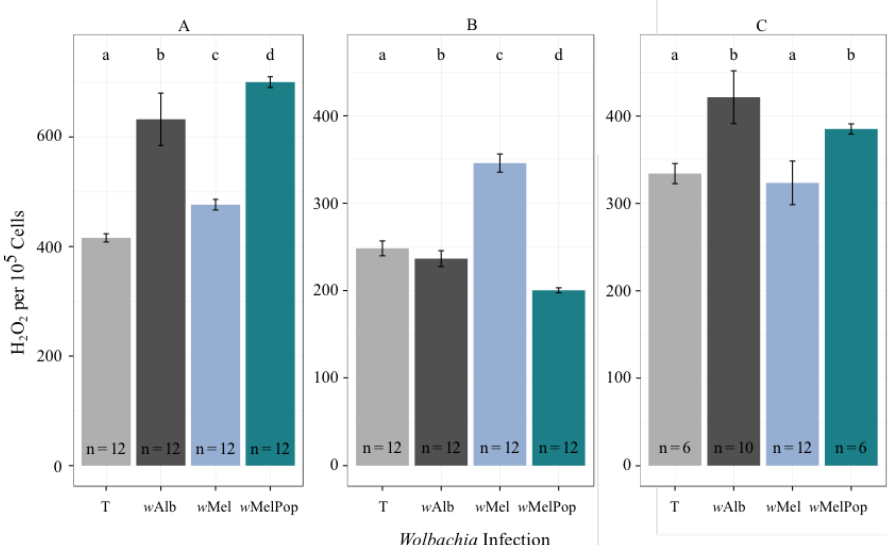
Figure 3. H 2 O 2 detected in Aa23-T cells, normalised to cell count. Graphs A, B and C represent independent experiments. Bars represent mean of n samples as shown and error bars represent the standard deviation of the mean. Lower case letters represent significant pairwise differences at p <0.05 derived from Kruskal-Wallis tests.